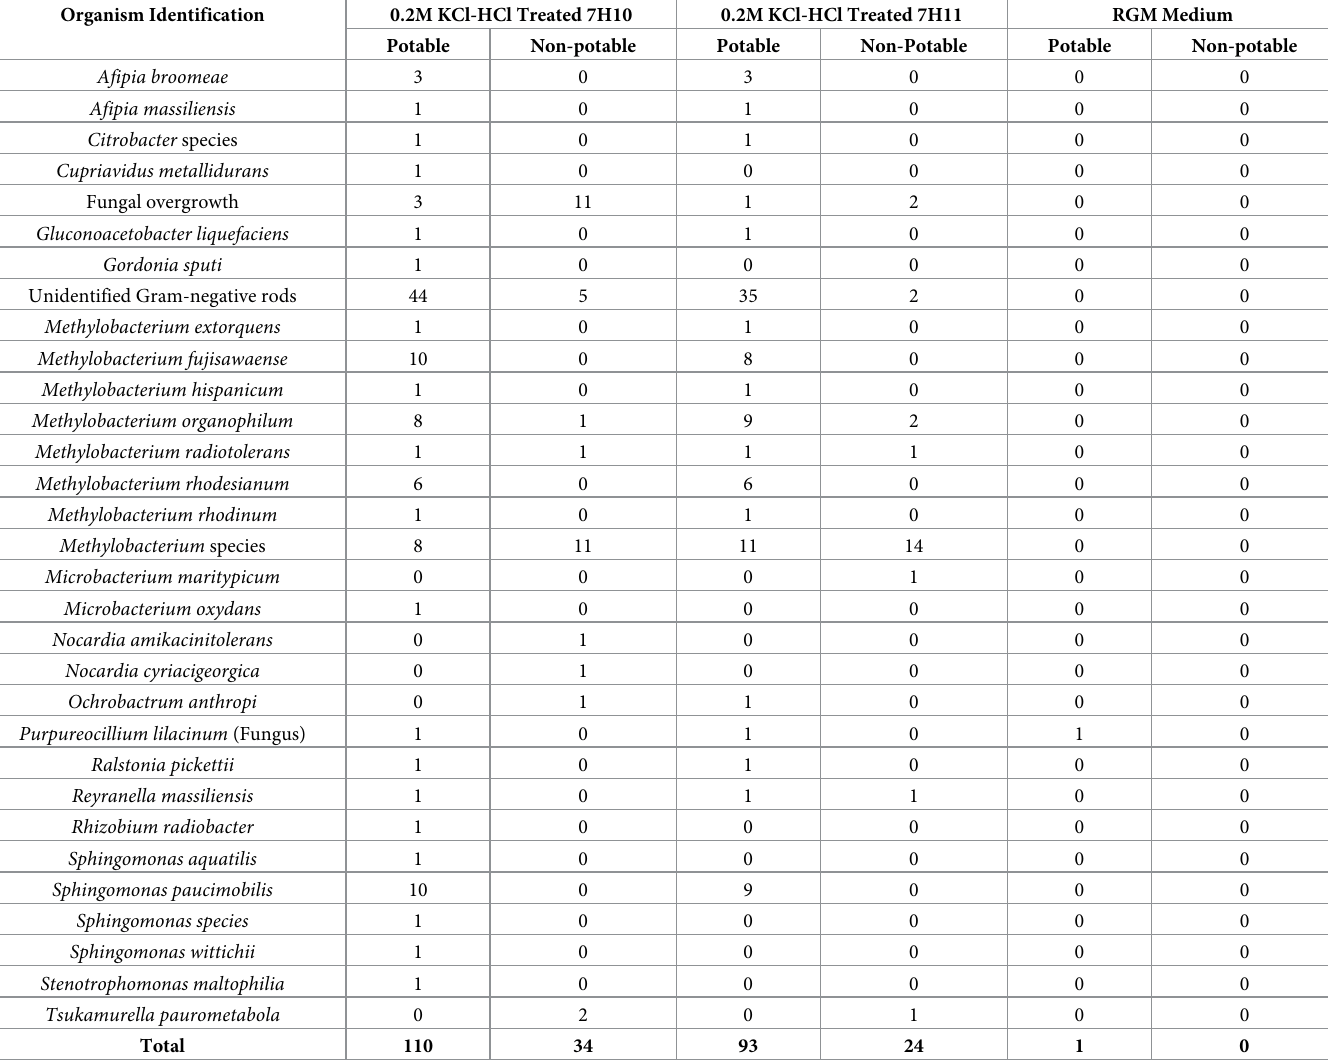
Table 3. Identification of non-mycobacterial species on 7H10, 7H11, and RGM